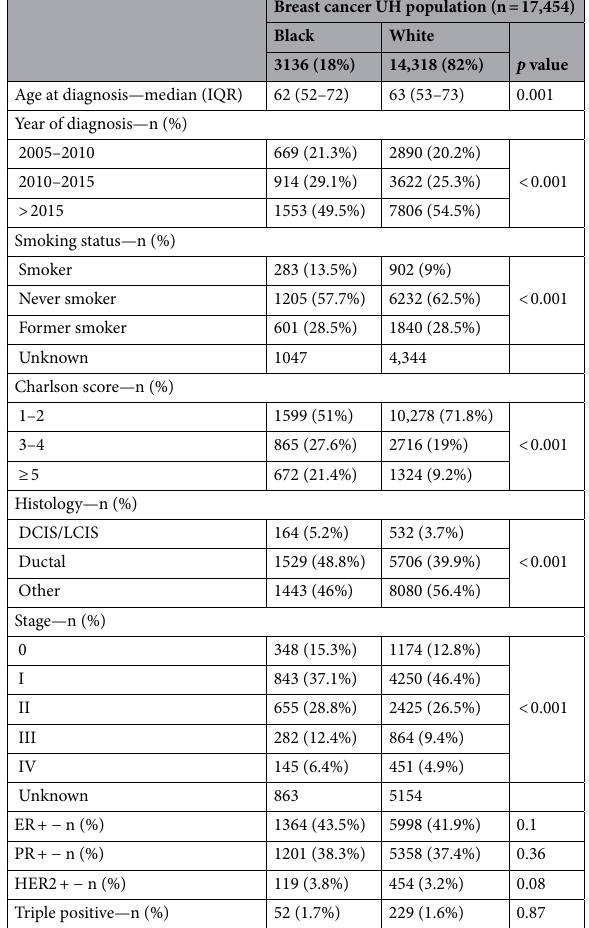
40.9%), immunotherapy (4.1% vs. 2.8%, p < 0.001), and combined therapy (including combined modality and combined systemic therapy). Stratifying the analysis by specific medications (Table 2), NHBs were prescribed both anthracycline containing (11.4% vs. 7.4%, p < 0.001), and non-anthracycline containing chemotherapy reg- imens (22.1% vs. 15.5%, p < 0.001) at a significantly higher rates. We also found that NHB were prescribed endo-